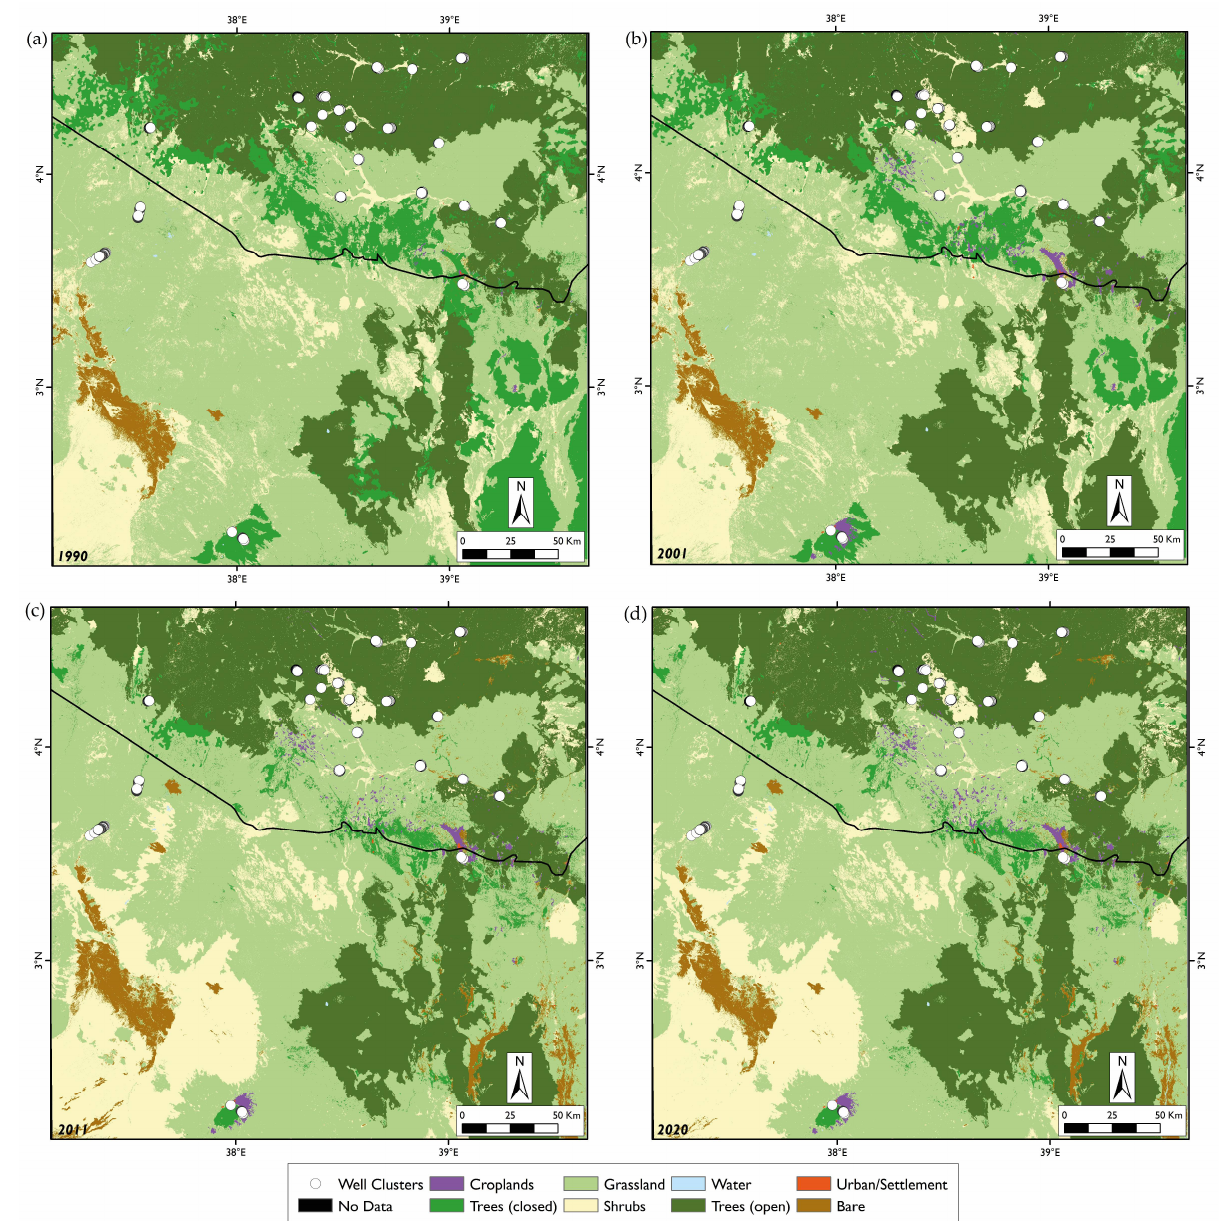
Figure 6. Classified land cover maps for: ( a ) 1990, ( b ) 2001, ( c ) 2011 and ( d )